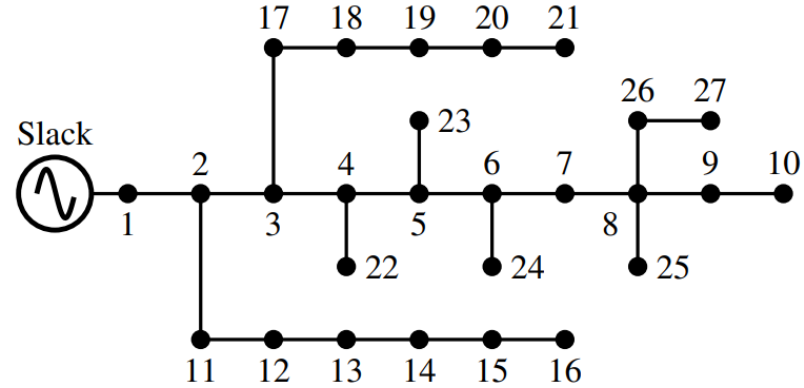
Figure 3. Single-line diagram for the 27-bus test system. The data on how the lines are connected to the different buses and their length are levels of both active and reactive load present in each bus are